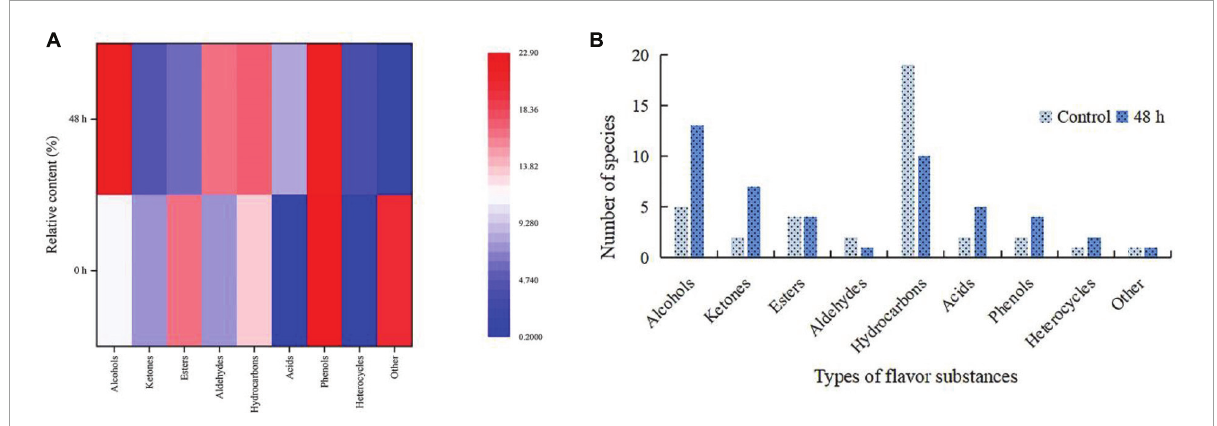
FIGURE4 Changes in relative content (A) and number of species (B) of volatile flavor compounds in Ginkgo biloba kernel juice fermented by Y2 for 48 h.